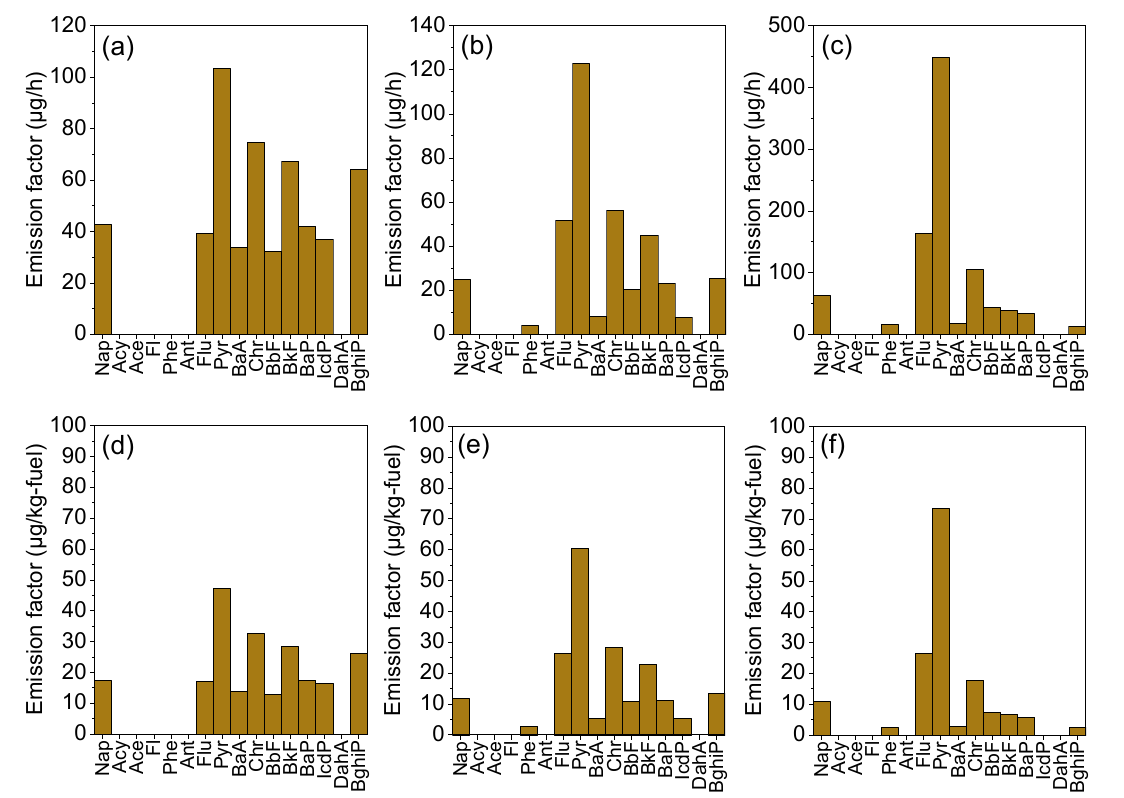
Figure 4. PAH emission factors: ( a ) time ‐ specific emission factors for WL; ( b ) time ‐ specific emission factors for FL; ( c ) time ‐ specific emission factors for EX; ( d ) fuel ‐ specific emission factors for WL; ( e ) fuel ‐ specific emission factors for FL; ( f ) fuel ‐ specific emission factors for EX.